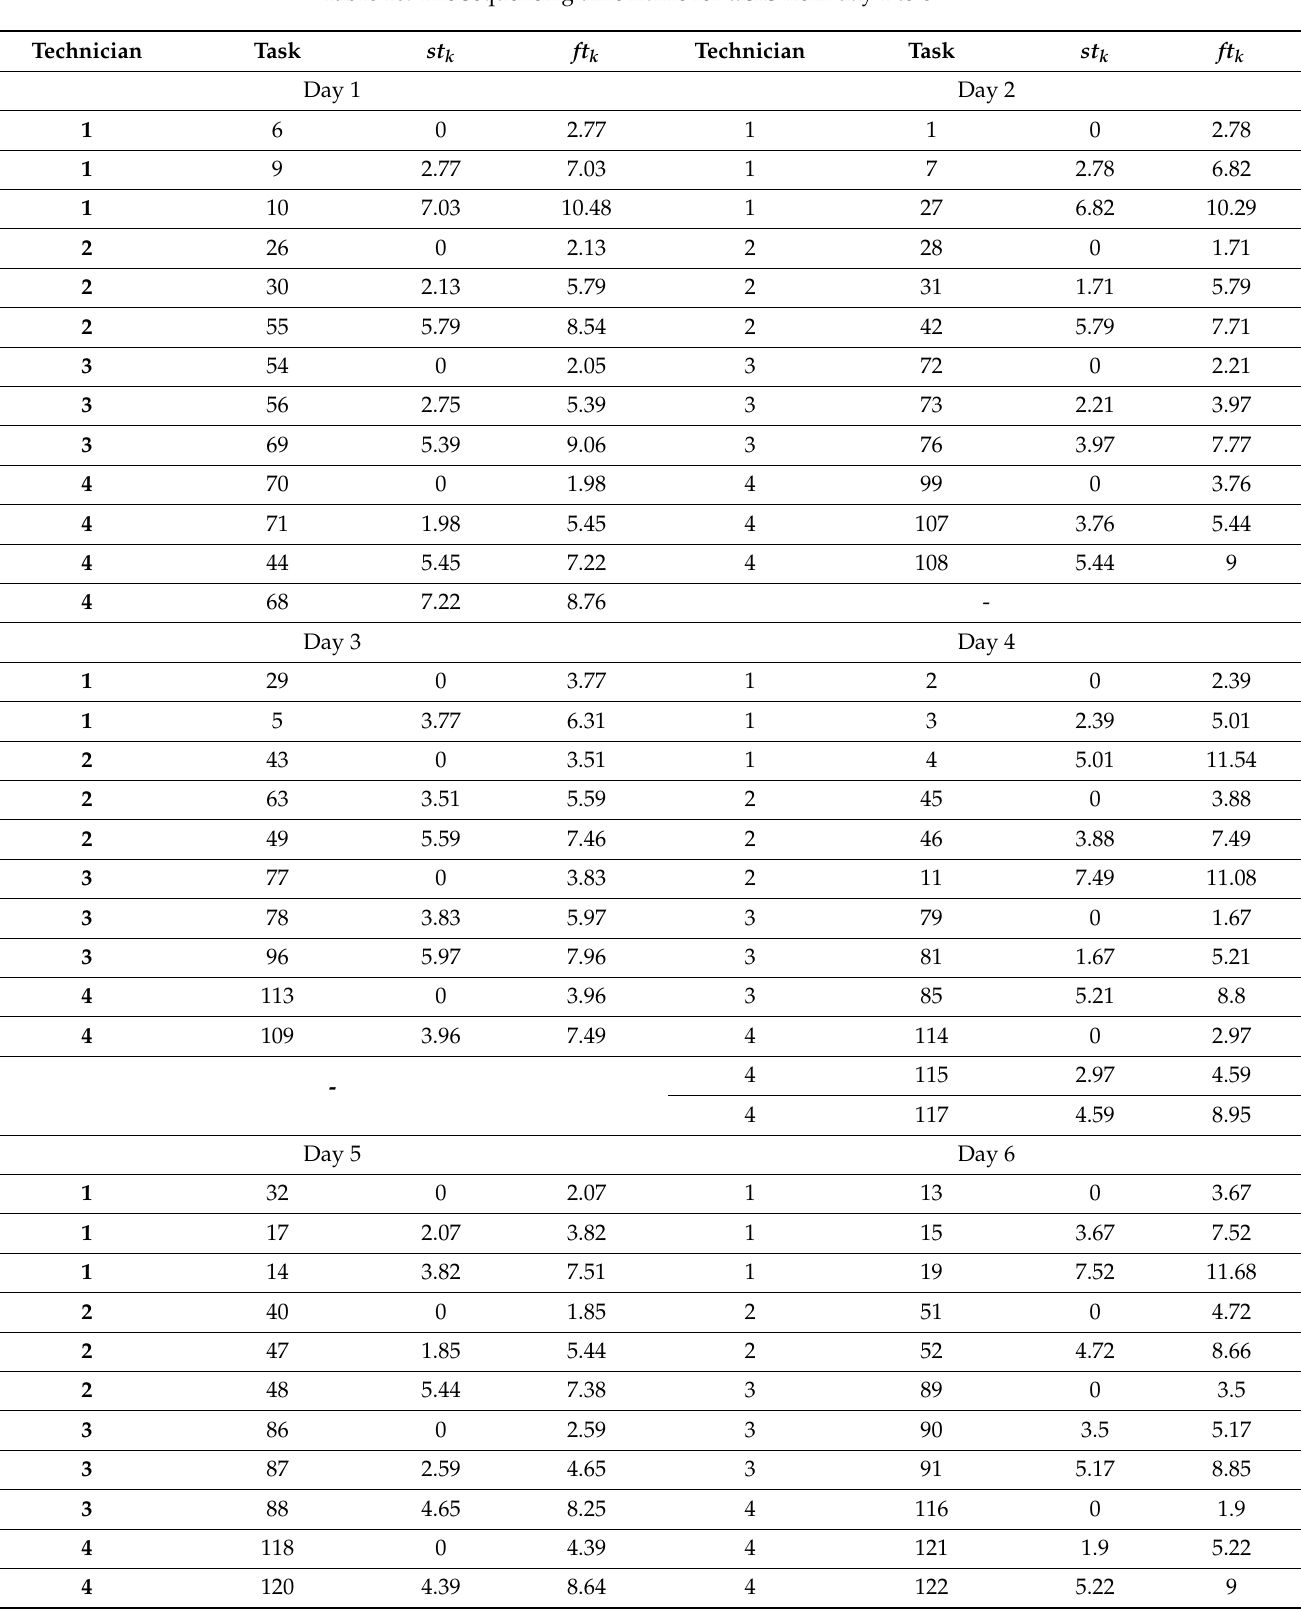
Table 10. The sequencing time frame for tasks from day 1 to